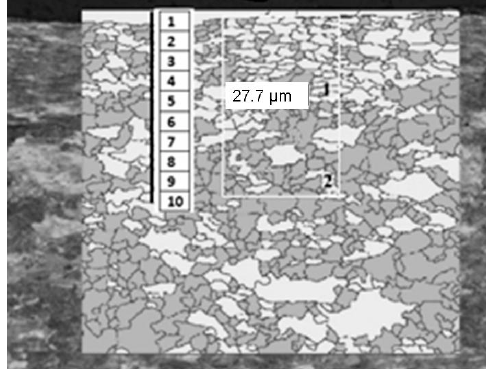
Figure 5. Locations where the coefficient of anisotropy was determined.